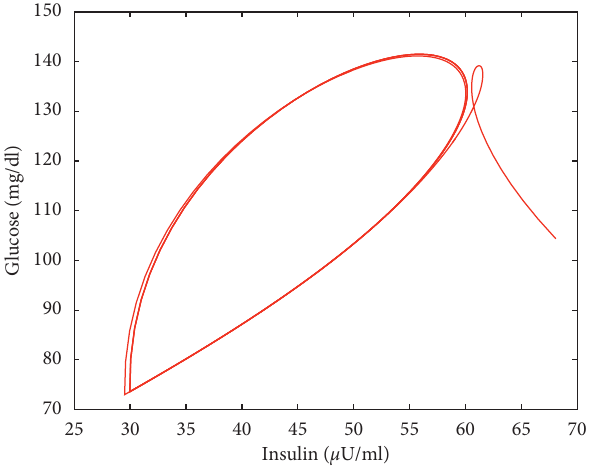
Figure 2: Phase diagram of system (5).